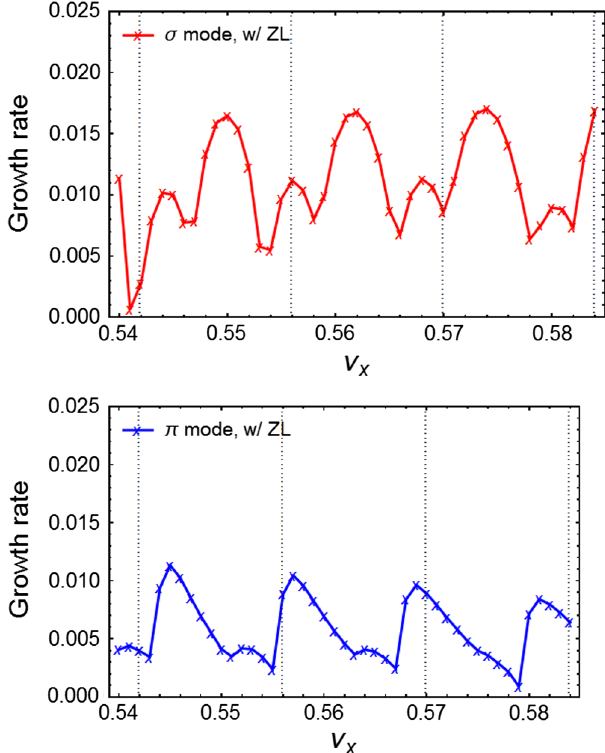
FIG. 10. Real part of eigenvector x mode as a function of J for σ mode, where ν ð J Þ is calculated with linear interpolation. The J axes is in the x ffiffiffiffiffiffiffiffiffiffiffiffi p l 2 J= ϵ unit of . z